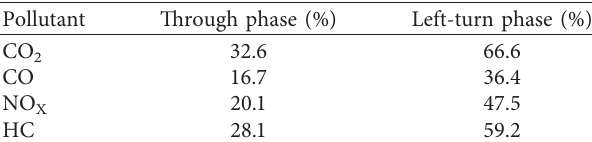
Figure 6: Emission increase of CO after pedestrian and nonmotorized vehicle violations based on the volumes of vehicles, nonmotor vehicles, and pedestrians. (a) Through phase. (b) Left-turn phase. Table 6: Maximum emission increase of pedestrian and nonmo- torized vehicle violations.